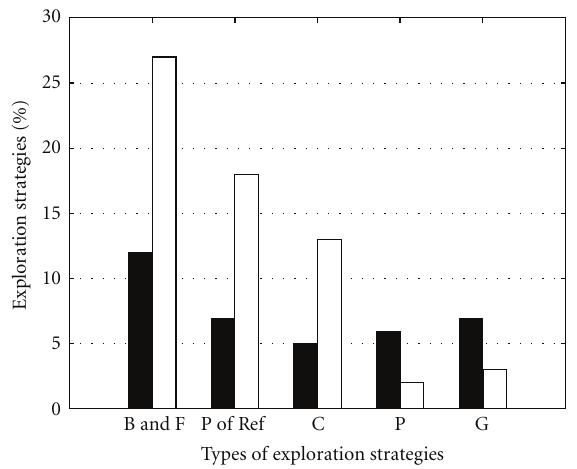
Figure 4: Frequencies of each exploration pattern during the inves- tigation (black) and memorization (white) phases. (B & F = “back- and-forth”; P of Ref = “point of reference”; C = “cyclic”; P = “perimeter”; G = “grid”).